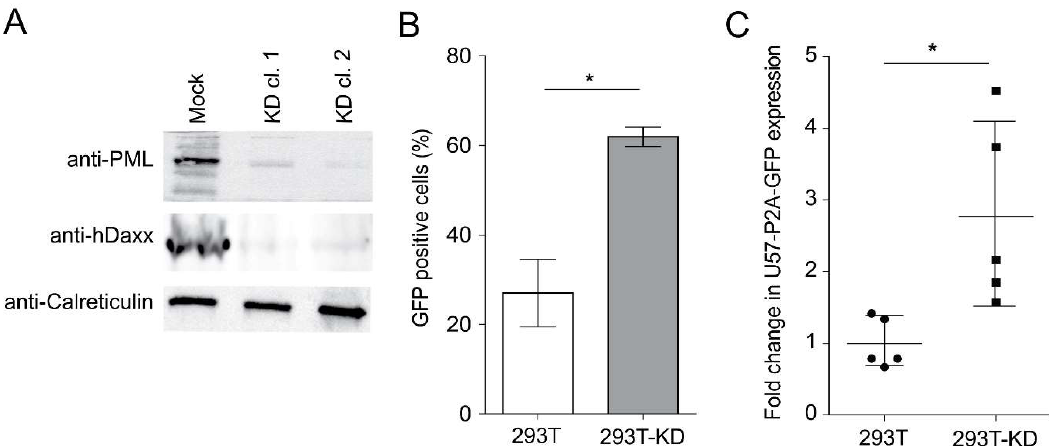
Figure 4. Depletion of ND10 components in 293T cells and its effects on HHV-6A gene expression. ( A ) PML and hDaxx knockdown was assessed in two independent 293T knockdown cell clones by western blotting. ( B ) Quantification of the GFP expression in 293T and 293T-KD clone 2 cells at three days = post-transfection with the HHV-6A-GFP BAC by FACS. Results are shown as the mean of three independent experiments with standard errors (*, p < 0.05). ( C ) Quantification of the expression of the major capsid protein U57 (late gene) by FACS in 293T and 293T-KD clone 2 cells five days post HHV-6A-U57-p2a-GFP BAC transfection by FACS. Results are shown as the mean of three independent experiments with standard errors (*, p < 0.05).